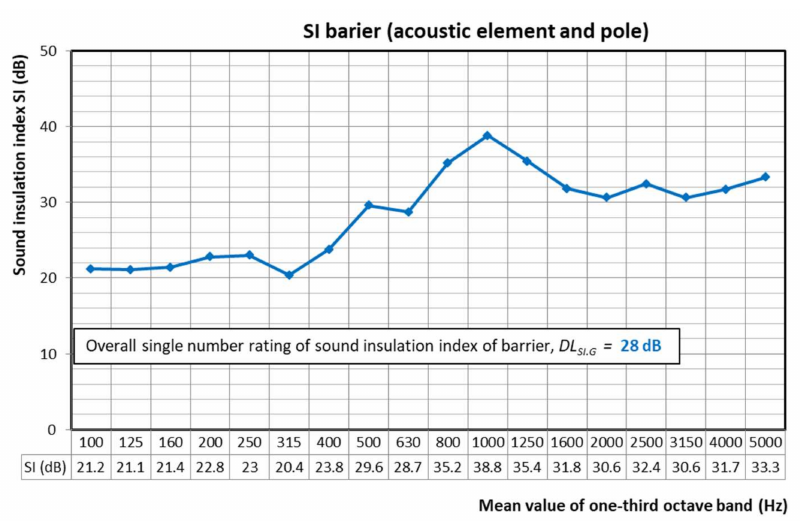
Figure 16. Diagram from the measurement of the airborne sound insulation index of the barrier. Measurement uncertainty: Reproducibility standard deviation for acoustic elements: 1.31 dB. Reproducibility standard deviation for poles: 0.92